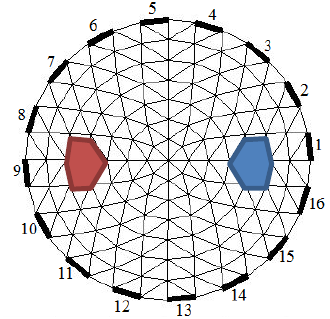
Figure 13. The triangular element model used in this study. Table 2. Data of the electrical properties many tissue from Gabriel.